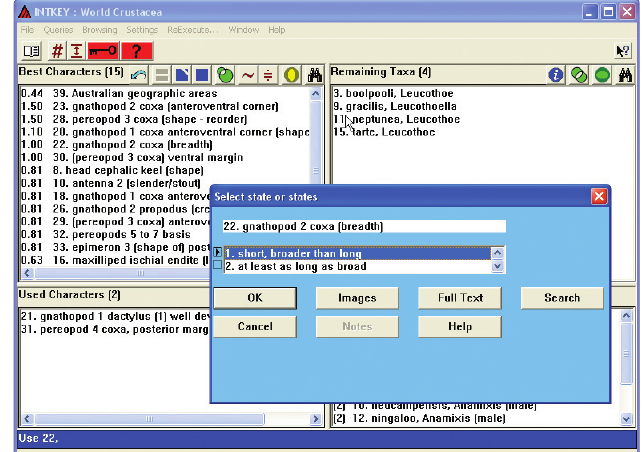
Figure 72. Character 22 has a Best index of 1.0 which is ideal for identifi